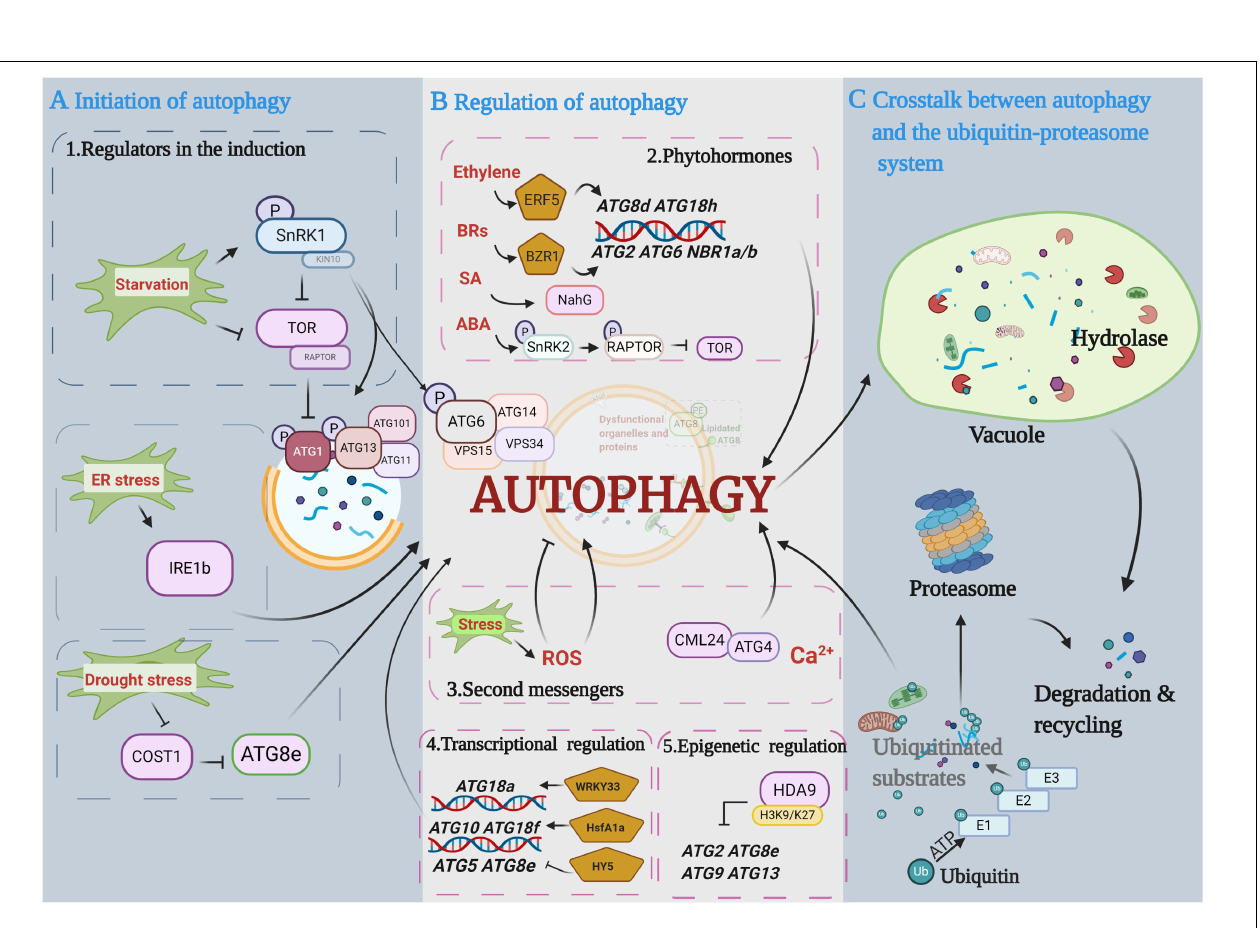
Frontiers in Plant Science |